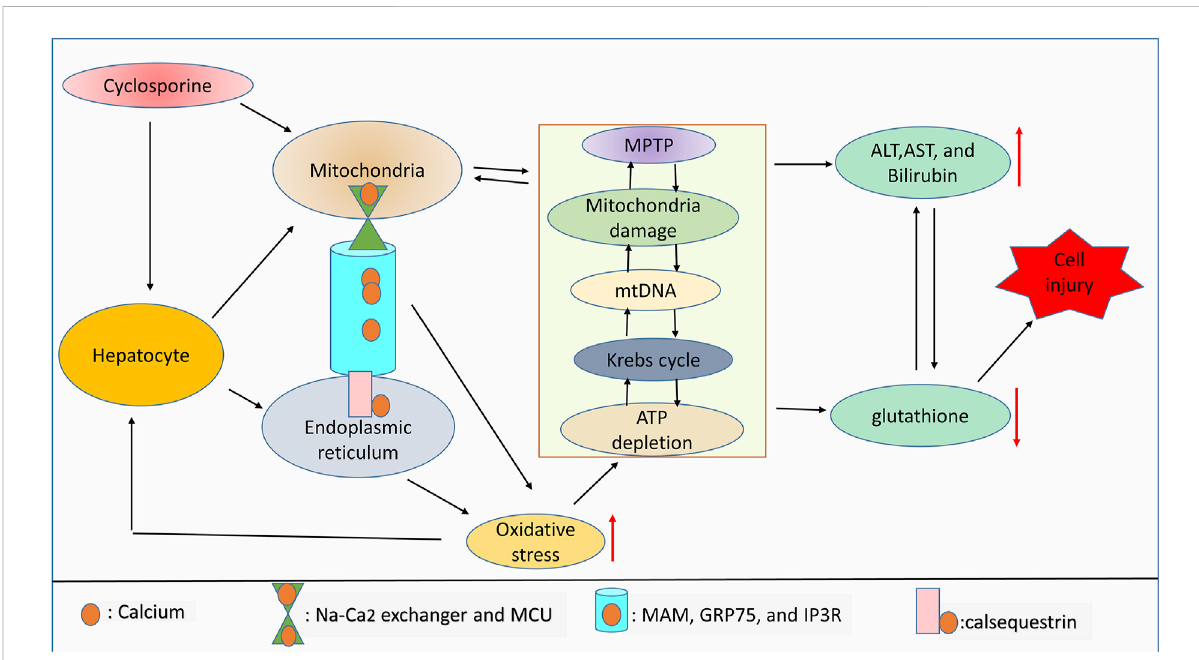
FIGURE 2 ROSand interorganellecommunication.Notably,calsequestrinregulatescalciumdynamicityinsidetheendoplasmic reticulum,whereasMAM, GRP75, and IP3R regulate the movement of calcium from the endoplasmic reticulum into mitochondria. Inside mitochondria, calcium movement is controlled by the Na-Ca 2 exchanger and MCU. Dysregulation of this endoplasmic reticulum-mitochondria collaboration due to drug toxicity can leadtooxidativestressgeneration.AberrantcalciumsignalingandhighlevelsofROScanaffectmitochondrialintegrity,mitochondrialfunction, andATPproduction.MitochondrialdamageandhighlevelsofROSareassociatedwithantioxidantdepletionandlimitedliverfunction,whichleadsto cellinjury.Therefore,Mitochondrialdamagewill indirectlycorrelatewiththeincreaseoflivercellinjurymarkersincludingALT, AST,andbilirubin due to the drug toxicity-induced high ROS